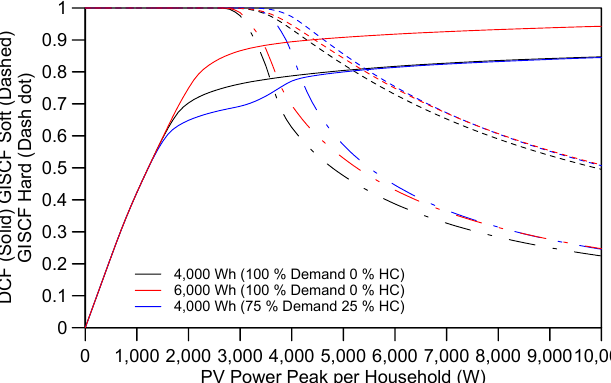
Figure 13. Comparison between the increase in the storage capacity and the application of grid interaction optimization techniques.